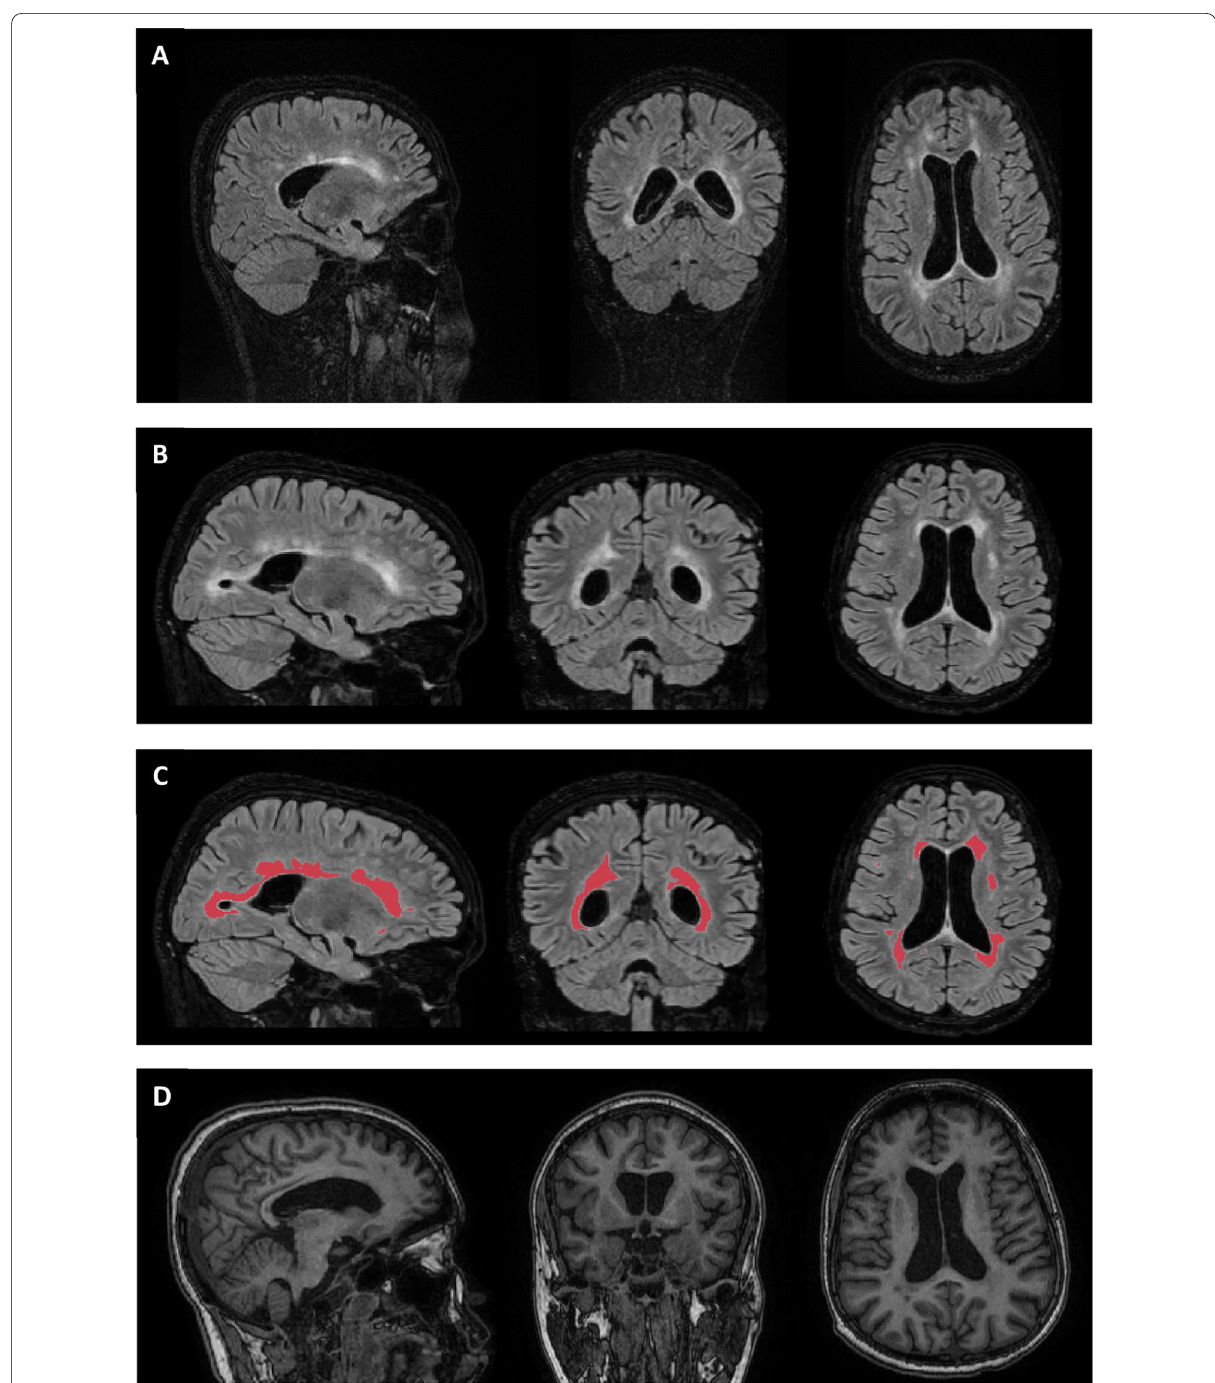
Fig. 7 A male patient aged 27 years, known to have RRMS with EDSS score of 3.5. White matter lesions segmentation: T2 FLAIR images in sagittal, coronal, and axial planes; a raw unprocessed image showing white matter hyperintense lesions located at the periventricular and white matter, b T2 FLAIR image after registration to MNI template and c processed T2 FLAIR image with segmented white matter lesions. Deep grey matter structures segmentation: T1W images in sagittal, coronal and axial planes; d raw unprocessed T1W images, e T1W images after registration to MNI template, and f and g T1W images with coloured segmented grey matter structures with thalamus in orange, caudate in red, putamen in green, and hippocampus in blue. Grey matter structures volumes after correction for ICV: Left and right thalamus: 0.00395 and 0.00321 cm 3 , left and right caudate: 0.00275 and 0.00273 cm 3 , left and right putamen: 0.00262 and 0.00261 cm 3 , left and right hippocampus: 0.00229 and 0.00263 cm 3 . White matter lesions volume: 1.7 cm 3 . We found that the patient had a significant decrease in the volumes of the putamen bilaterally, right thalamus, and left hippocampus, and he had white matter lesions volume of 1.7 cm 3 and EDSS score of